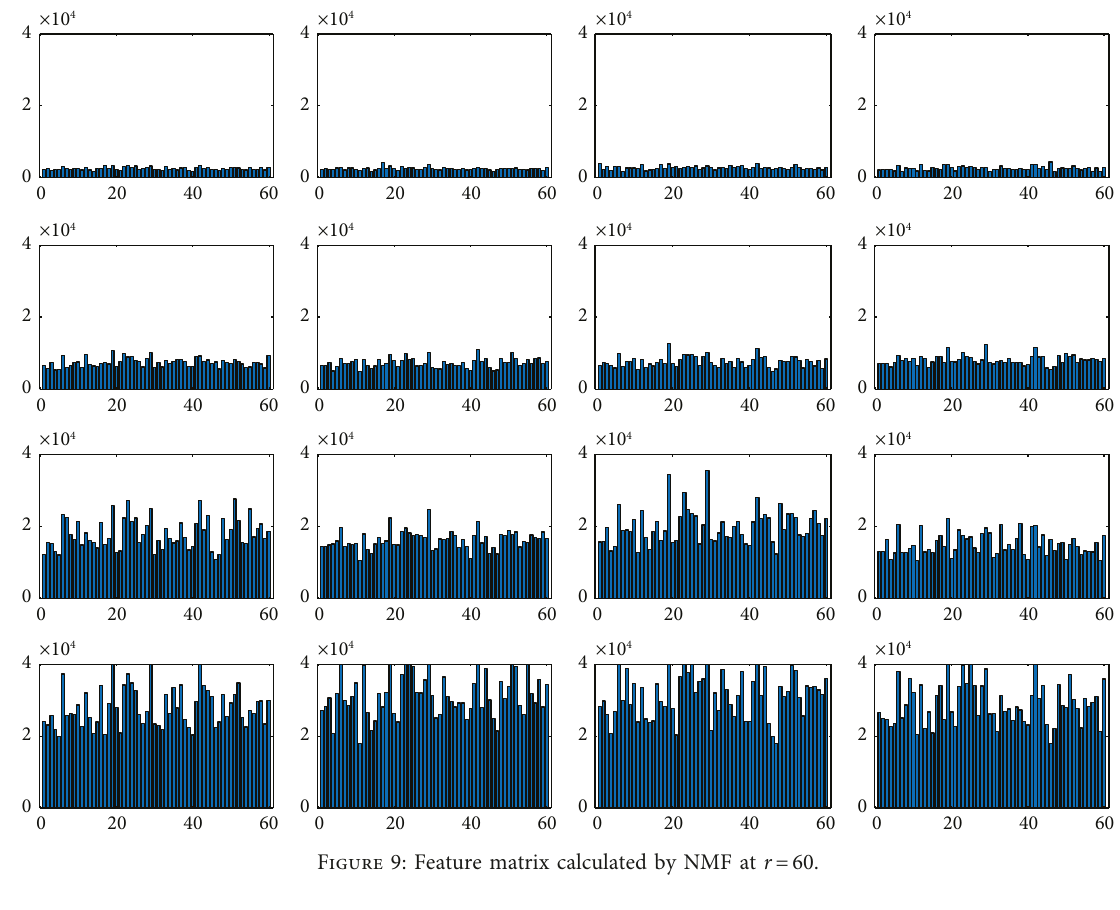
Figure 9: Feature matrix calculated by NMF at r �